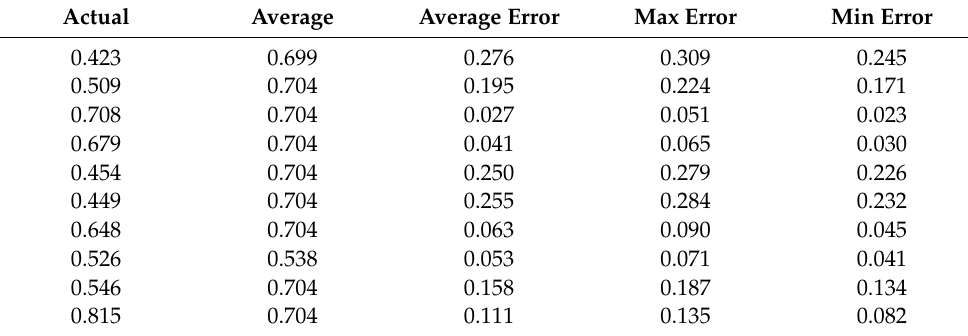
Table A20. Set 1, trials 11–20 data (average actual PR values).